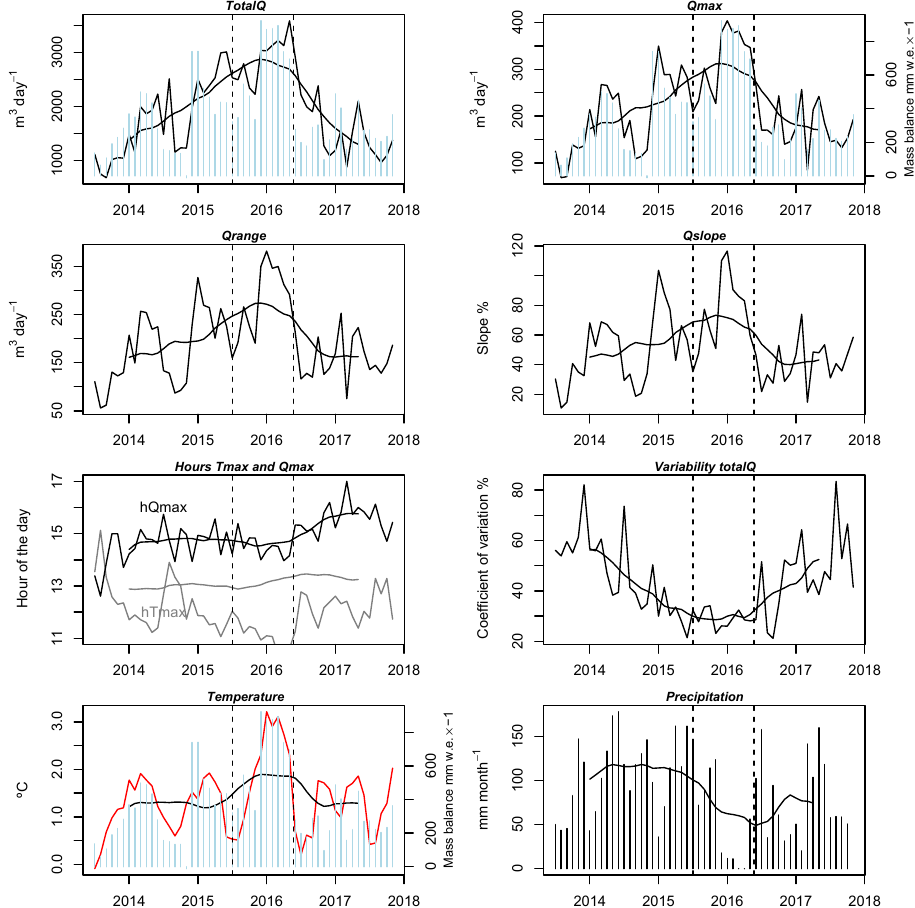
Figure 6. Evolution of monthly averaged hydrological indices, temperature, precipitation and glacier mass balance (in blue bars), for the study period. Dashed lines indicate the 2015–2016 strong El Niño event. The 12-month window moving averages (black smooth lines) are shown to represent